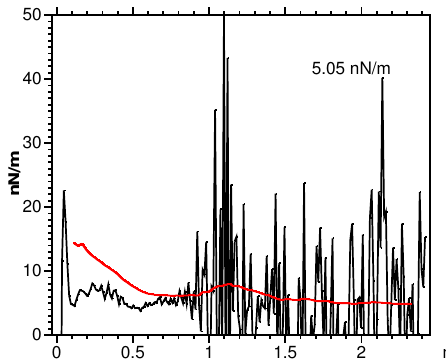
Figure 10. Run Proton: same as Fig. 2, but in proton